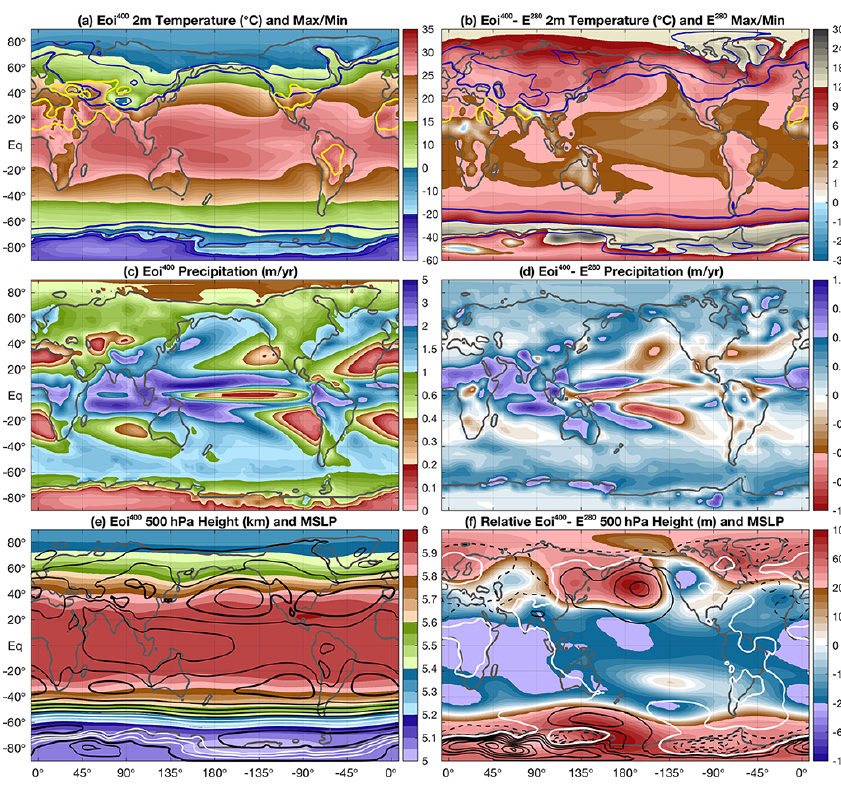
Figure 4. Annual mean atmospheric model fields from our Eoi 400 case (a, c, e) and the Eoi 400 − E 280 difference. (a, b) Near-surface (2m) air temperature (shading), warmest-month mean maximum (yellow contour at 40 ◦ C), and coldest-month mean minimum (blue contours at 0, − 20, and − 40 ◦ C). Contours in (a) are for Eoi 400 , and those in (b) are for E 280 . Panels (c, d) show precipitation (myr − 1 ); differences in (d) are smoothed over land. Panel (e) shows the height of the 500hPa pressure level (shading) and mean sea level pressure (MSLP; contours every 5hPa; black: ≤ 1000hPa; white: < 1000hPa; thick line every 20hPa). Panel (f) shows the 500hPa height difference with respect to the global average Eoi 400 − E 280 value (i.e. 96m); contours are used for MSLP (every 2hPa, solid: > 0: dashed: < 0; thick white line at